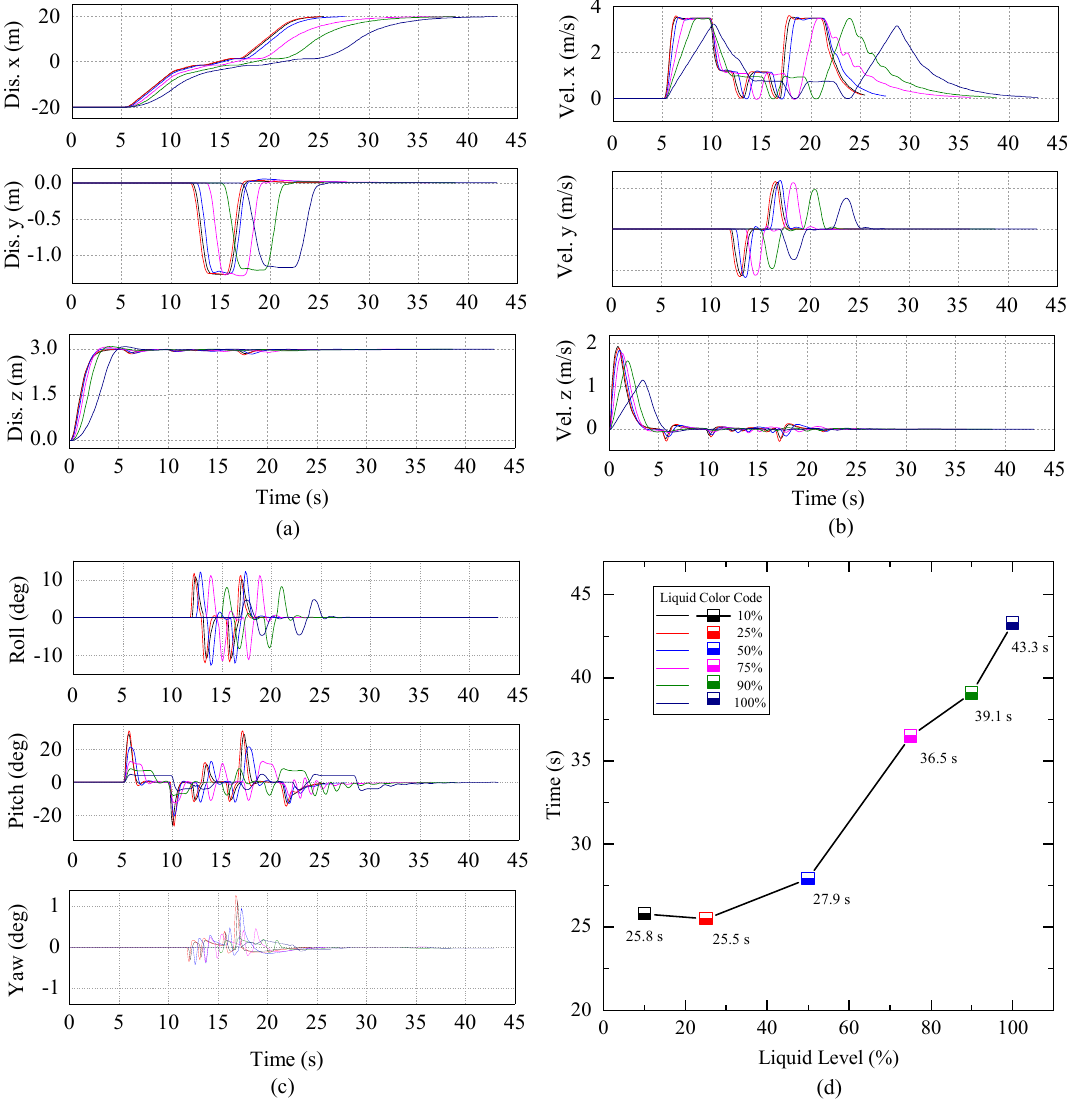
Figure 11. Flight history using different liquid levels. ( a ) x , y , z distance; ( b ) x , y , z velocity; ( c ) roll, pitch and yaw; ( d ) total flight times carrying different liquid level.